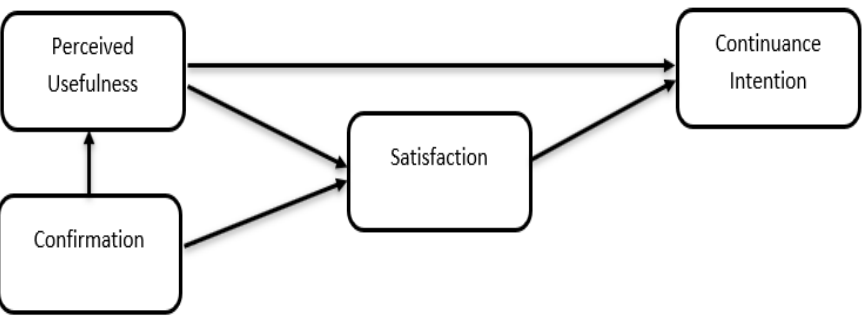
Figure 1. A framework of Expectation Confirmation Model. Source: developed by the authors based on Bhattacherjee (2001).